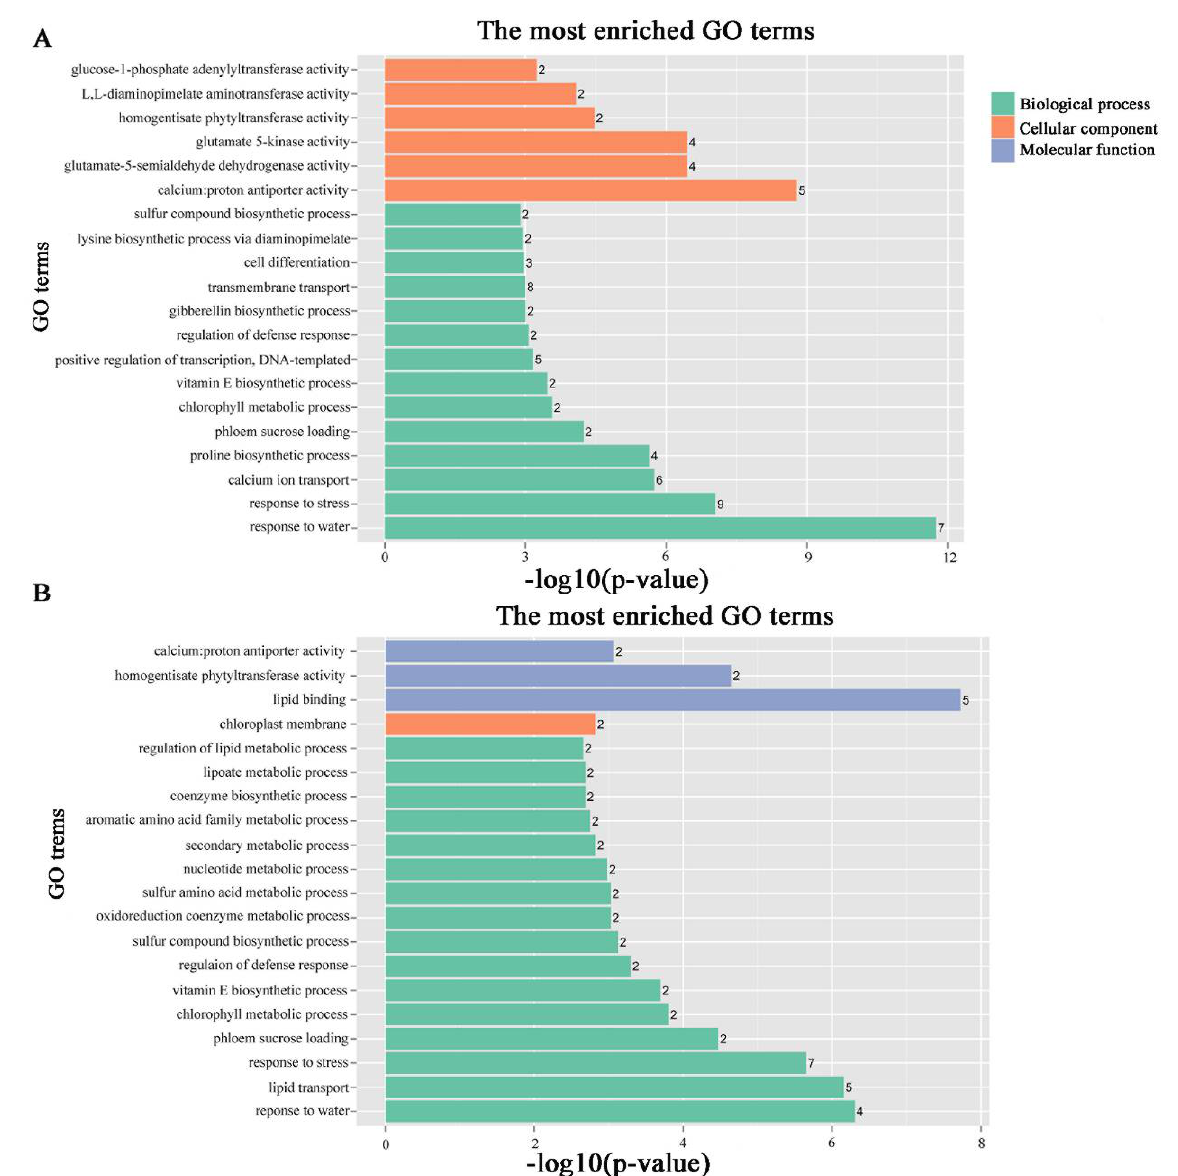
Figure 8. GO pathways associated with modules associated with stress-responsive traits. The number ahead of the items indicates the gene number. ( A ) Dark grey module GO pathways. ( B ) Purple module GO pathways.